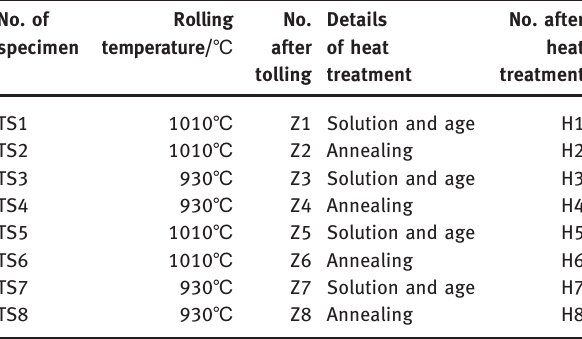
Table 1: Specimen number and experiment schemes of Ti6Al4V